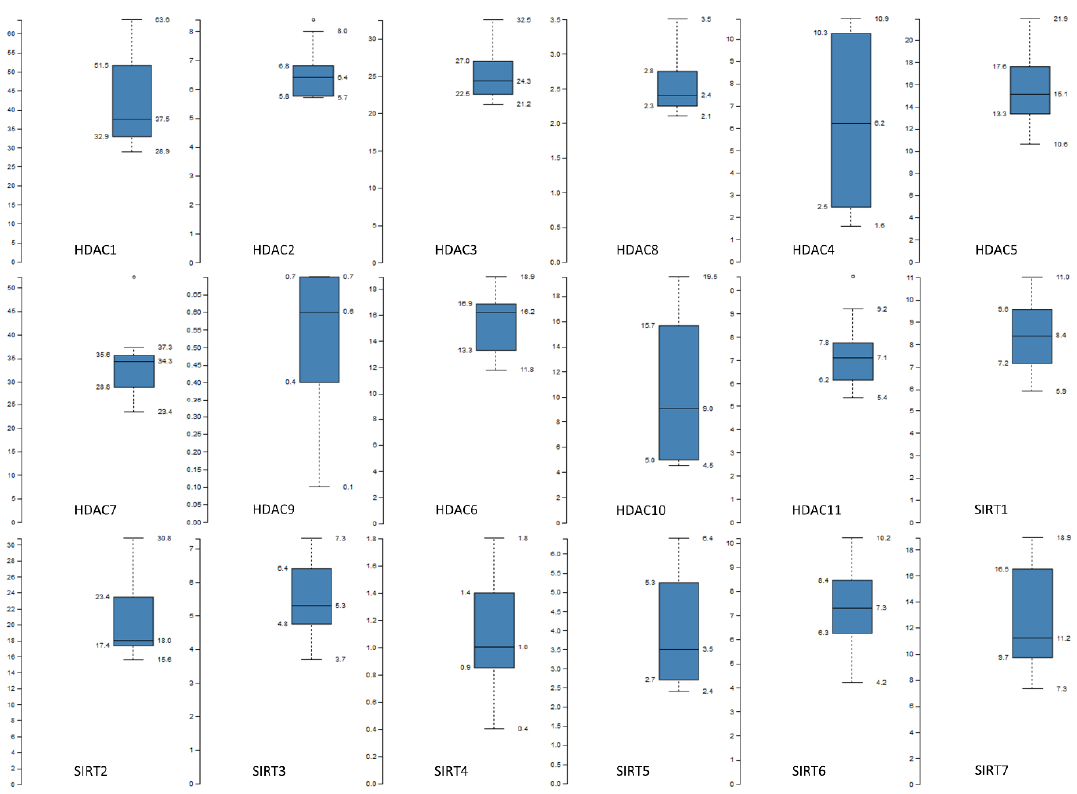
Figure 2. Quantification of HDAC expression levels in normal human urinary bladder tissues (n = 11), via employment of an RNA sequencing approach, with the median RPKM (reads per kilo base per million mapped reads) value for each member of the family being indicated on the right side of the respective horizontal line [129].